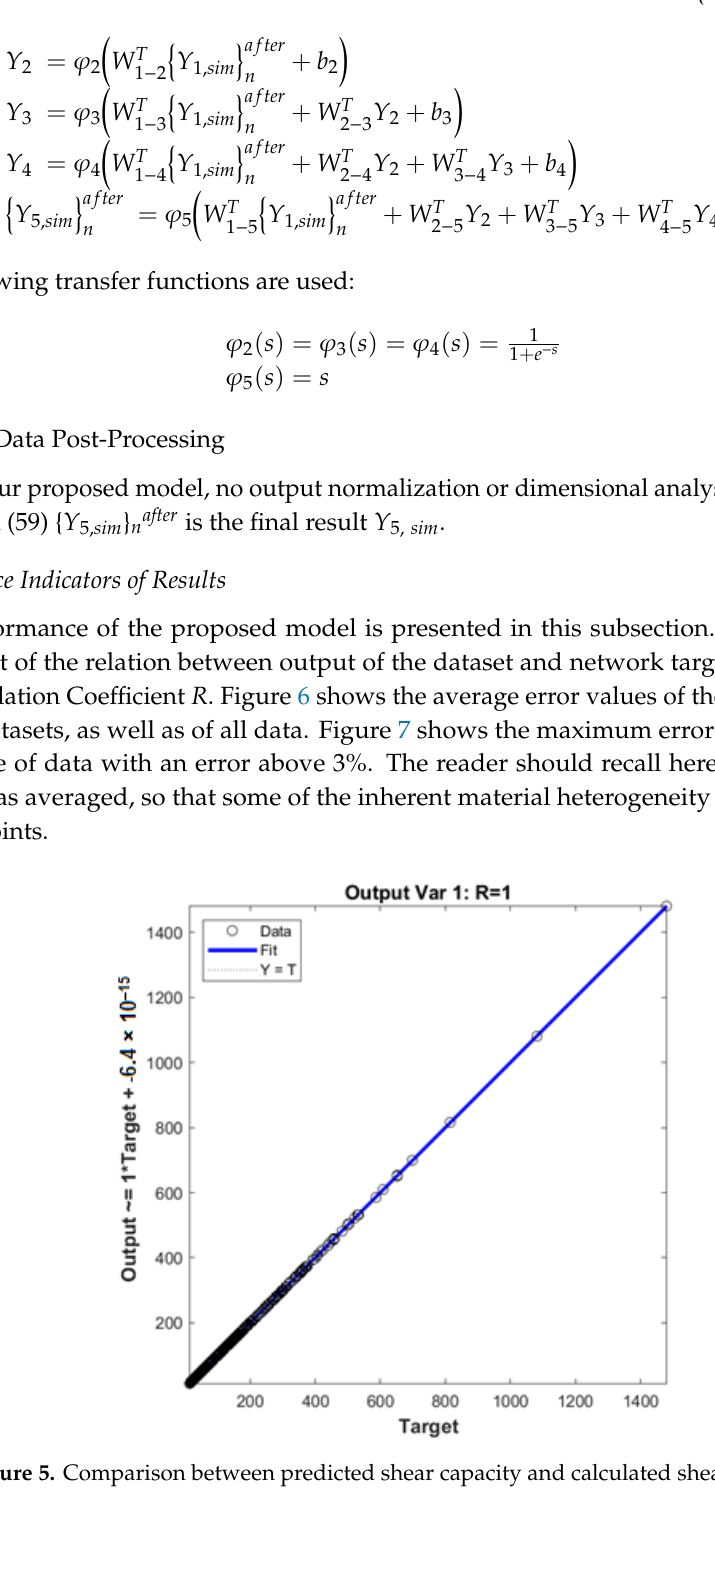
Figure 6. Mean error of the different considered datasets.